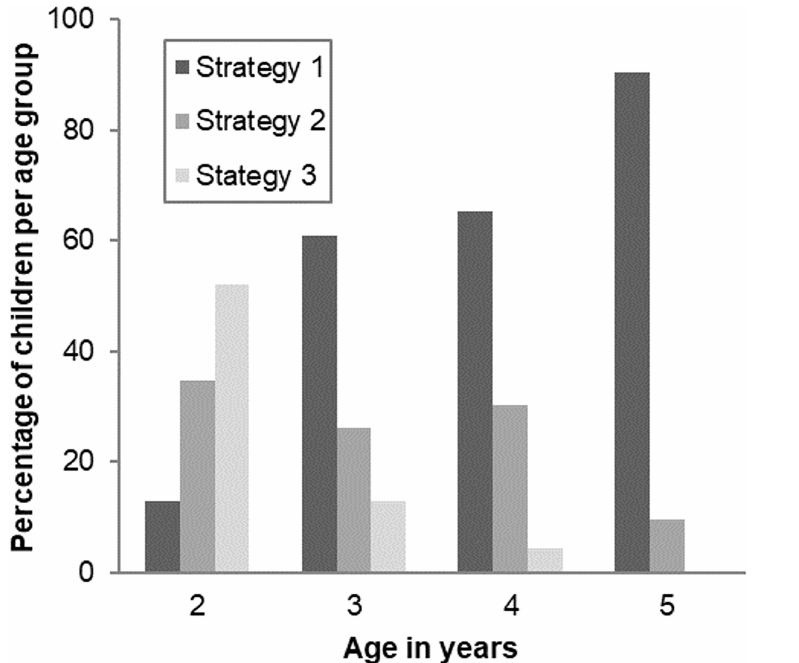
Fig 2. Selected latent class model: Percentages of children per strategy by age